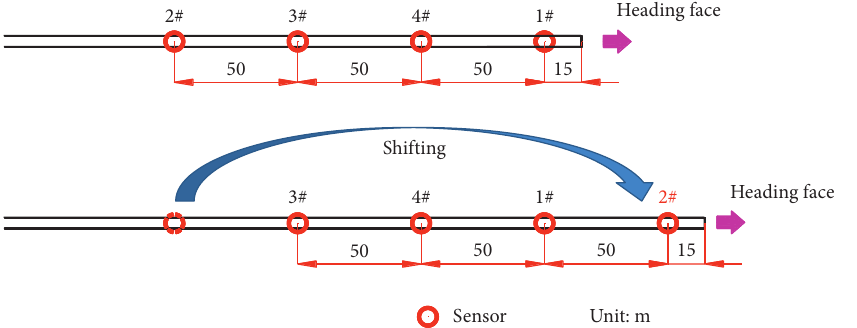
Figure 2: Shifting rule of sensor.